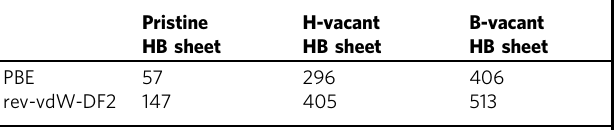
Table 2 Calculated adsorption energies of water on the HB sheet with PBE and rev-vdW-DF2